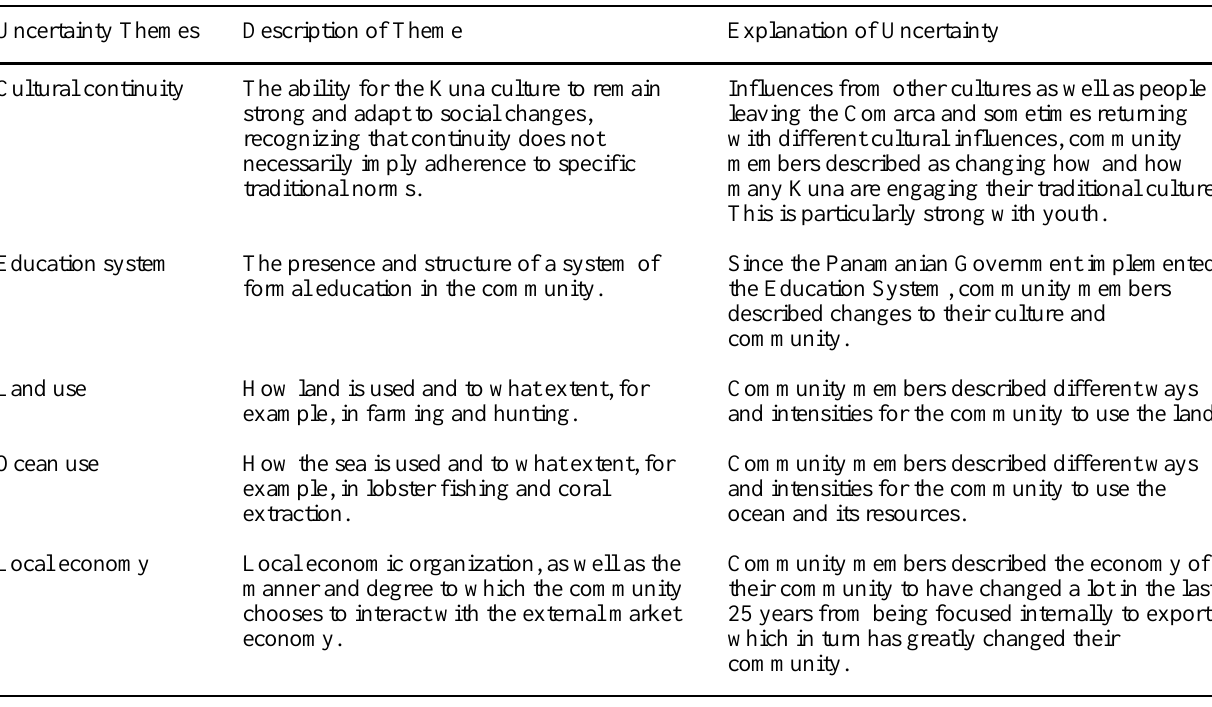
Table 1. Description and explanation of the uncertainty themes that were analyzed from data collected in stage one with semistructured